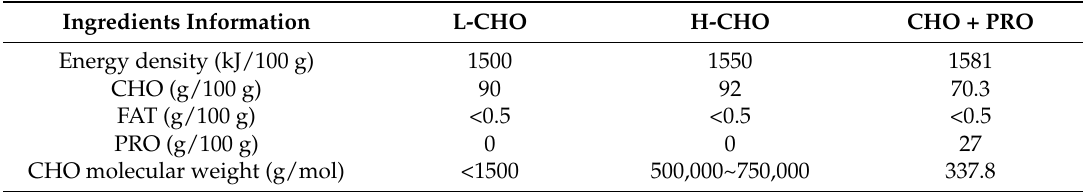
Table 1. Ingredients of prescribed sports beverages. CHO: carbohydrate; PRO: protein. Ingredients